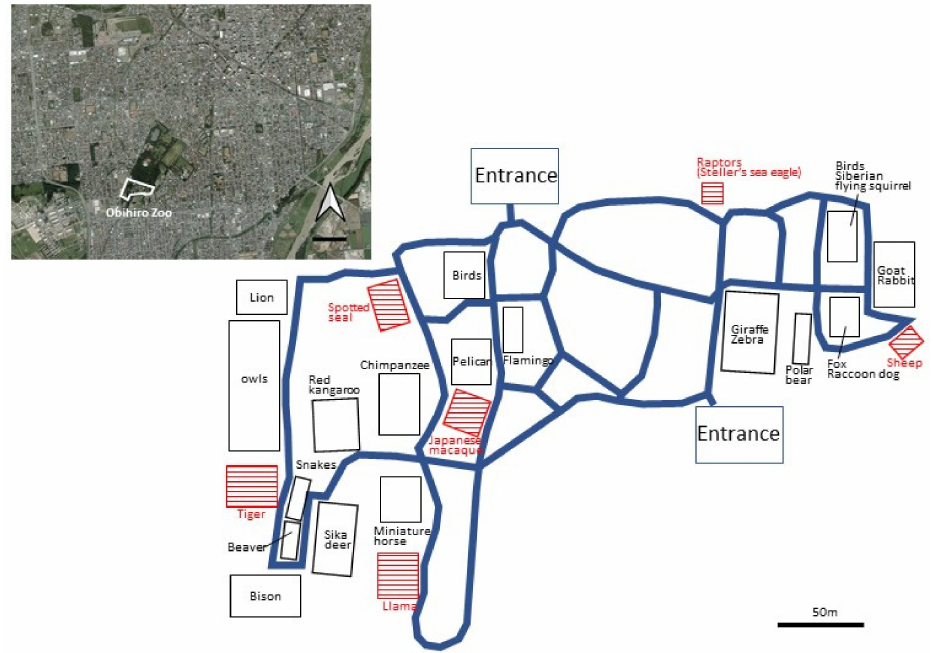
Figure 1. Enclosure arrangement of each animals in Obihiro